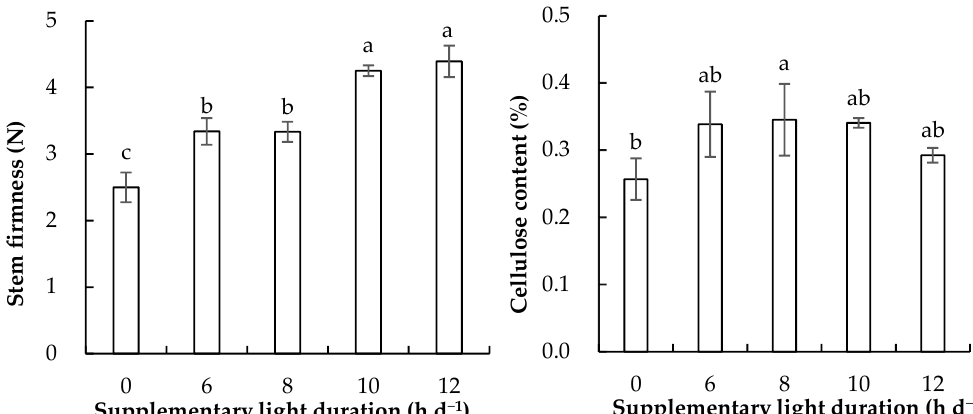
Figure 4. Effects of supplementary light duration with the same daily light integral on stem firmness and cellulose content of cucumber seedlings grown in the greenhouse for 21 days after sowing. Means followed by different letters within each parameter are significantly different based on the least significant difference (LSD) test ( p < 0.05). Error bars show ± standard deviation.